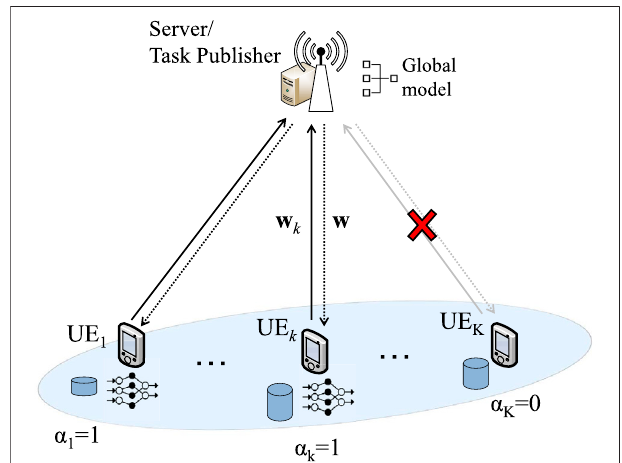
FIGURE 1 | WFL system